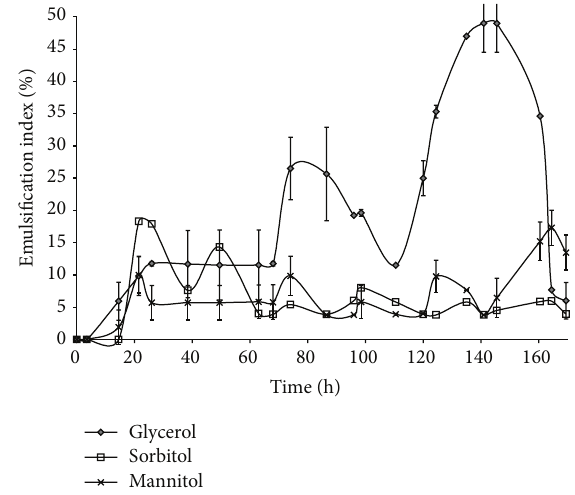
Figure 1: Selection of carbon source—one factor at a time.